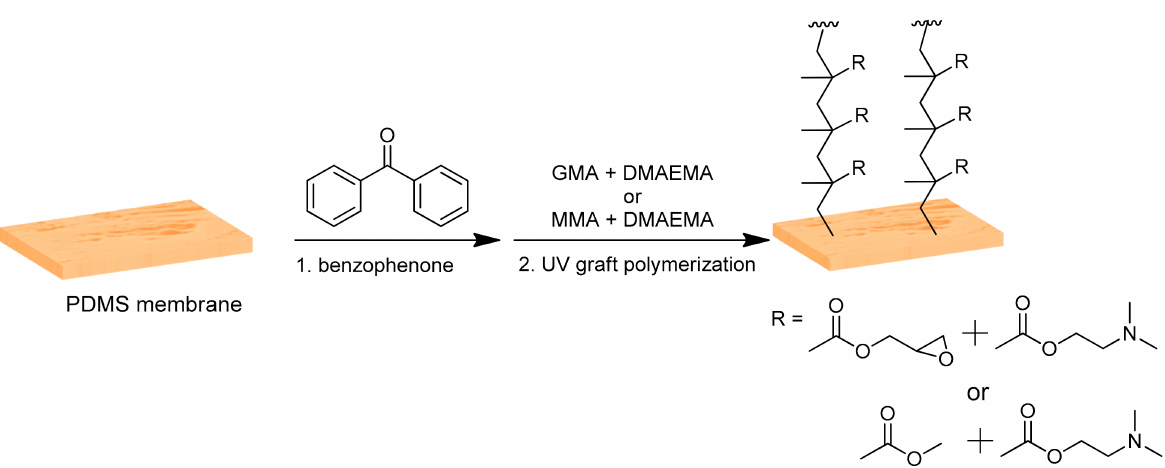
Figure 1. Ultra-violet grafting of polydimethylsiloxane membranes with the monomers glycidyl methacrylate or methyl methacrylate with 2-(dimethylamino)ethyl